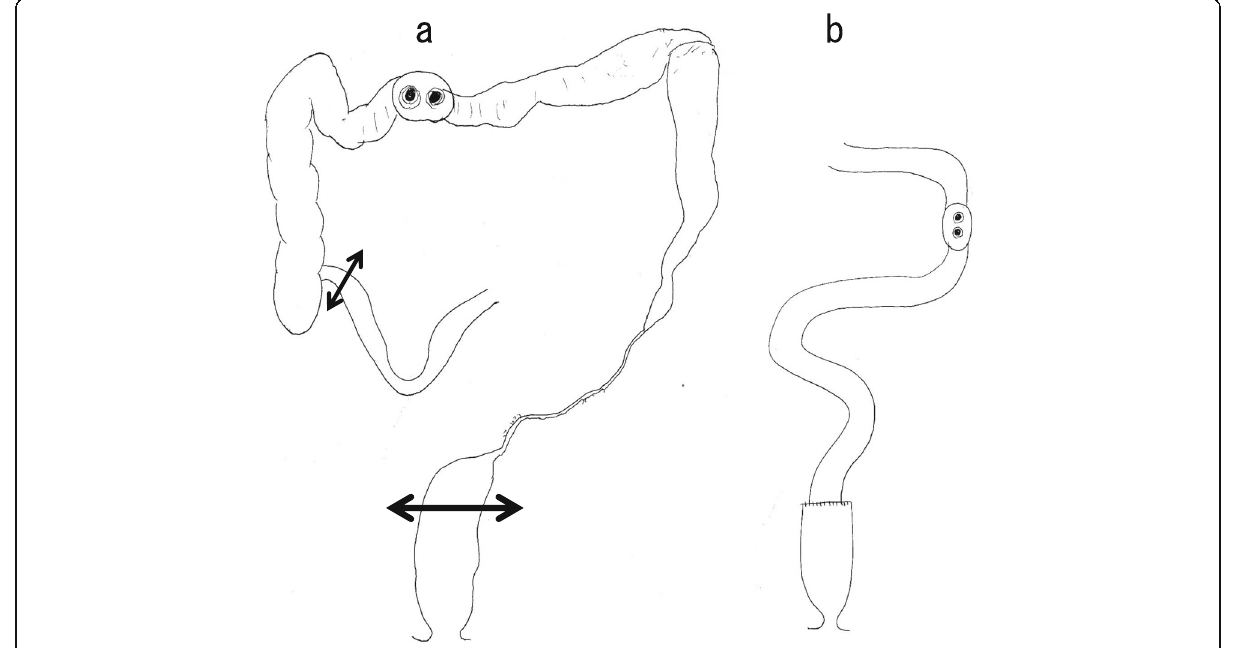
Fig. 8 Subtotal colectomy ( a ), ileorectal anastomosis, and ileostomy creation ( b ) were